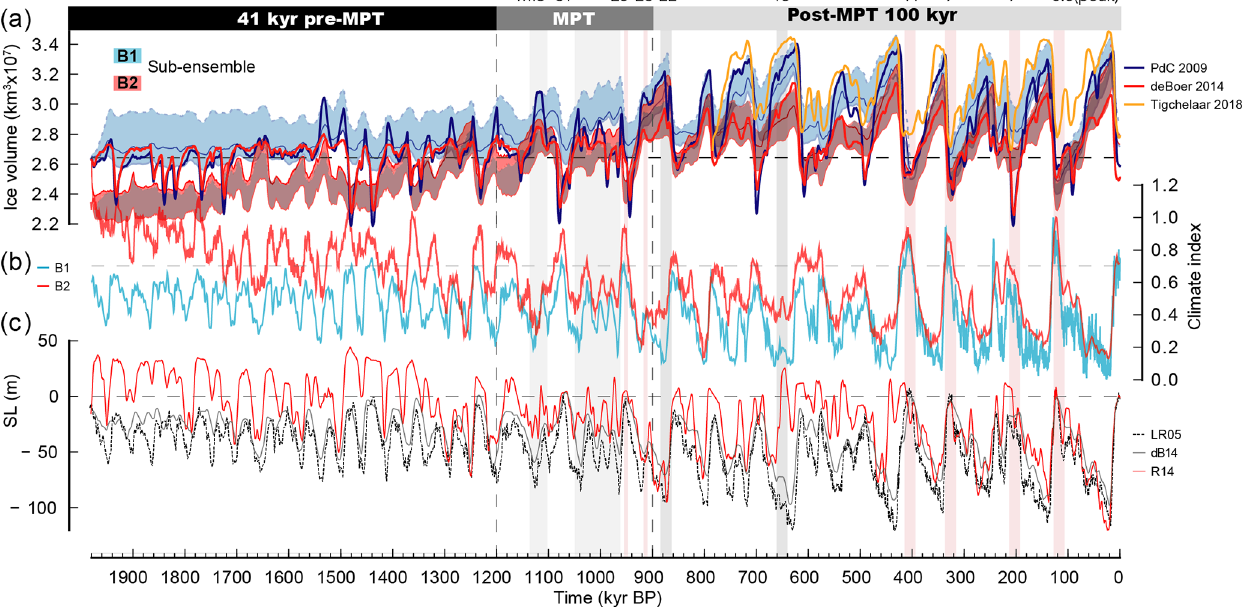
Figure 6. Panel (a) depicts the ice volume evolution of a subset of the model ensemble. Blue and light blue curves depict ensemble branch B1 with parameter set P2 (see Table 2) and sea level forcing LR04. Geothermal heat flux is depicted with the blue line (Shapiro and Ritzwoller, 2004), upper light blue dashed line (Purucker, 2013) and lower light blue line (Martos et al., 2017). The red curves show B2 with parameter set P1 and using the climate index from Snyder (2016). The red line refers to (Shapiro and Ritzwoller, 2004), the dashed maroon line refers to (Martos et al., 2017) and the maroon line refers to (Purucker, 2013). The simulated ice volume from Pollard and DeConto (2009), de Boer et al. (2014) and Tigchelaar et al. (2018) is shown for comparison (black, grey and black dashed line). (b) shows the climate index used in B1(dark grey) and B2 (light grey) with the horizontal grey dashed line depicting the average Holocene index. (c) shows the sea level reconstructions used in the model ensembles (Lisiecki and Raymo, 2005, LR04; de Boer et al., 2014, dB14; and Rohling et al., 2014, R14).